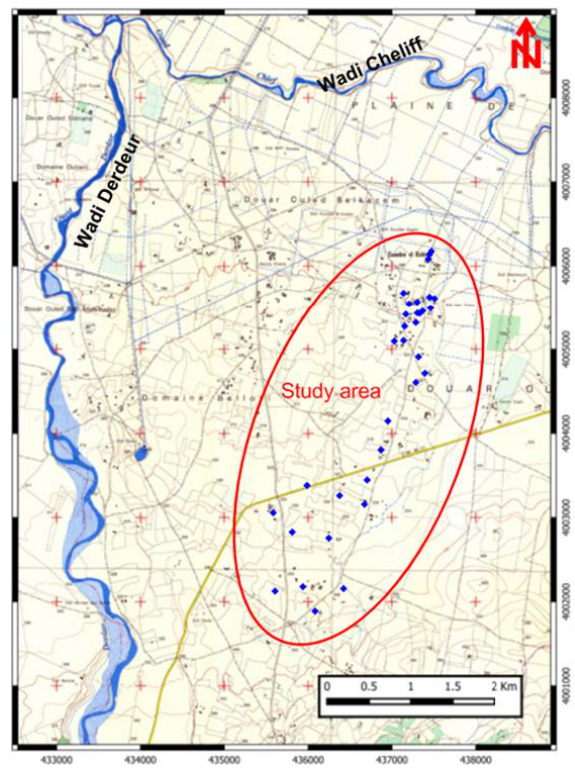
Fig. 3. Sampling points in the study